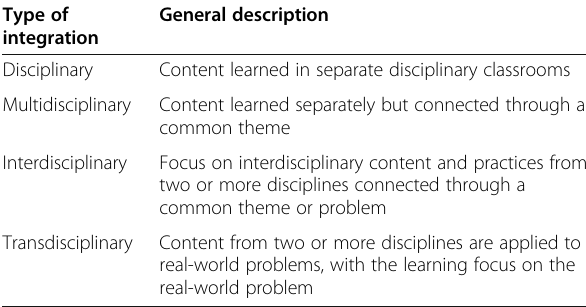
Table 1 Levels of STEM integration, adapted from Vasquez et al.